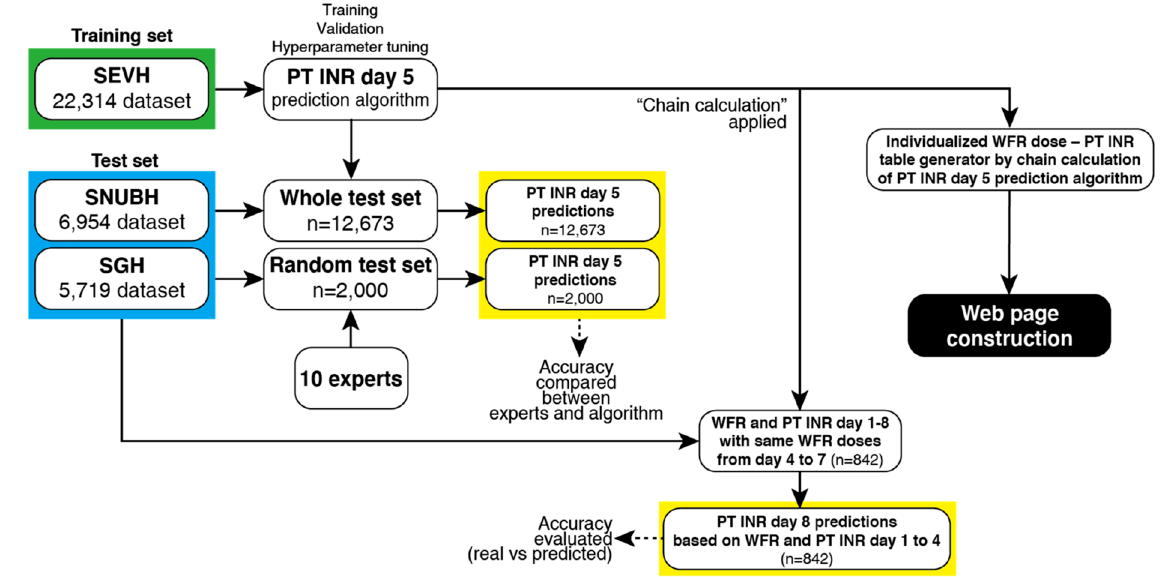
Figure 1. Complete architecture of the whole study. SEVH Severance Hospital, SNUBH Seoul National University Bundang Hospital, SGH Sejong General Hospital, PT INR prothrombin time international normalized ratio, WFR